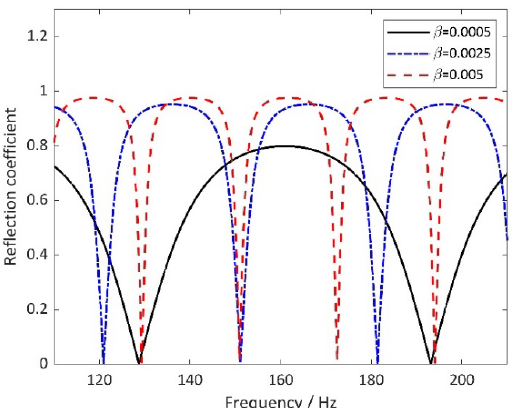
Figure 3. Frequency response of acoustic reflection coefficients in multilayer media containing bubbly liquid layers at different gas contents.